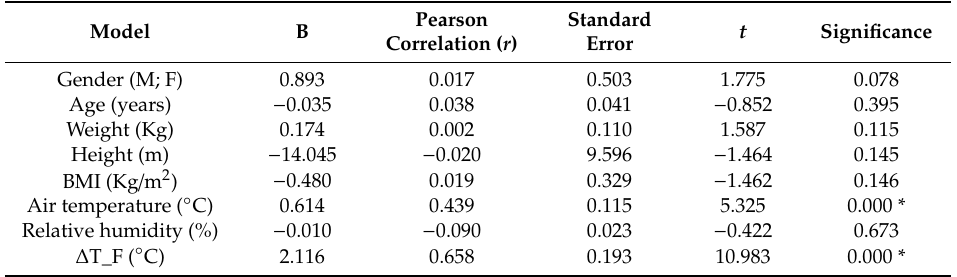
Table 11. Regression analysis using as independent variables: gender, age, weight, height, BMI, air temperature, relative humidity, and forearm skin temperature variation.